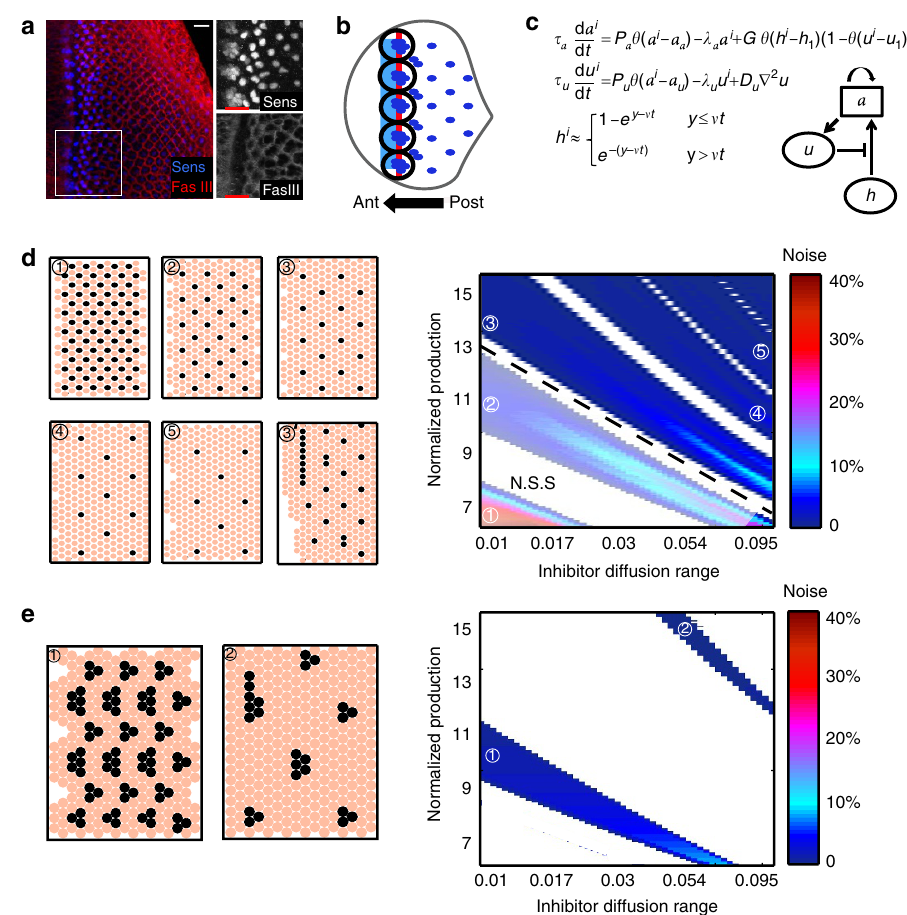
Figure 1 | A model of eye disc patterning. Here and in all figures posterior is to the right. ( a ) Confocal image of the developing disc. Cell outlines are visualized with FasIII (red), and differentiating cells with the nuclear differentiation marker Sens (blue). Inset: a magnified view of the boxed region, including and immediately posterior to the MF (red line). Scale bar, 10 m m. ( b ) Schematic representation of sens expression. ato is first expressed uniformly (blue stripe) anterior to the MF (red line), upon which it is refined into pro-neural clusters and expressed together with sens . ( c ) Equations and interactions are shown for the template-based lateral-inhibition patterning model. h denotes the long-range activator (representing Hh and Dpp), a the cell-autonomous activator (representing Ato and Sens) and u the diffusible inhibitor (representing Sca and the Egfr-dependent signal). Simulations are performed by discretizing the equations on a 42 (cid:2) 42 cell grid, with h value approximated by its analytical value (Supplementary equation (12.3)) whose approximation is shown here ( v represents wave velocity). t a and t u denote the typical timescales characterizing the dynamics of a and u , respectively; l a and l u are the respective degradation rates; P a and P u are the respective production rates; D u is the diffusion constant of u . y ( a ) is the Heaviside step function, which is equal to 1 for positive values and zero otherwise. The upper-script indexes ( i ) indicate the grid site and r 2 is the grid two-dimensional Laplacian operator. More details are given in Supplementary Note 1. ( d , e ) Parameters defining the inhibition range (effective diffusion, D u , and normalized production rate P u / u 1 ) were varied systematically, as shown. White regions denote parameter combinations where no periodic solution was found. Colour scale quantifies noise sensitivity by the maximal spatial variations that can be added without pattern failure. We examined patterns of solitary cells ( d ) and of clusters ( e ). Panel 3 0 demonstrates pattern failure after adding less than 5% noise to parameters generating the pattern in panel 3. For each parameter configuration, maximal noise is reported after simulating all possible initial conditions. The parameter space enclosed below the dashed line (N.S.S; non-sufficient spacing) yields patterns in which the area surrounding each cluster does not comprise the required 20 cells forming the ommatidium. See Supplementary Methods for details of how noise was defined and Supplementary Table 1 for the parameters